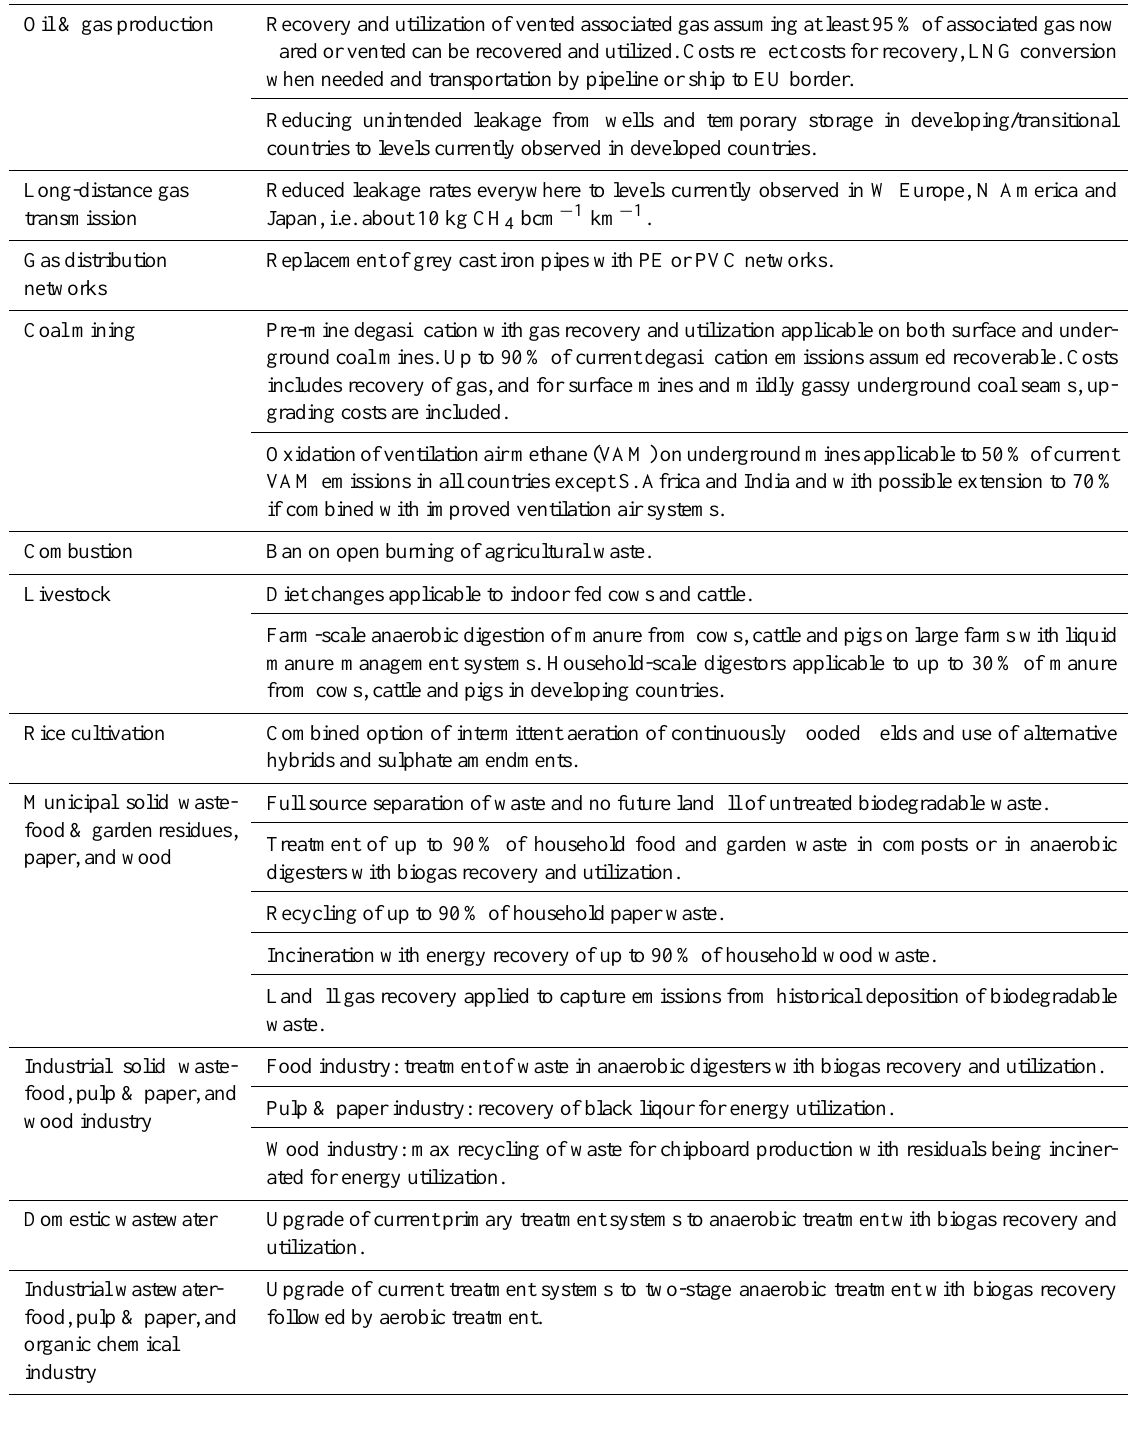
Table 3. CH 4 mitigation measures in the GAINS model. Emission source